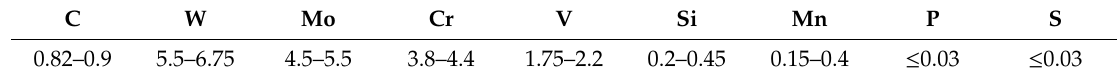
Table 3. The chemical composition of steel EN HS6-5-2 (%).